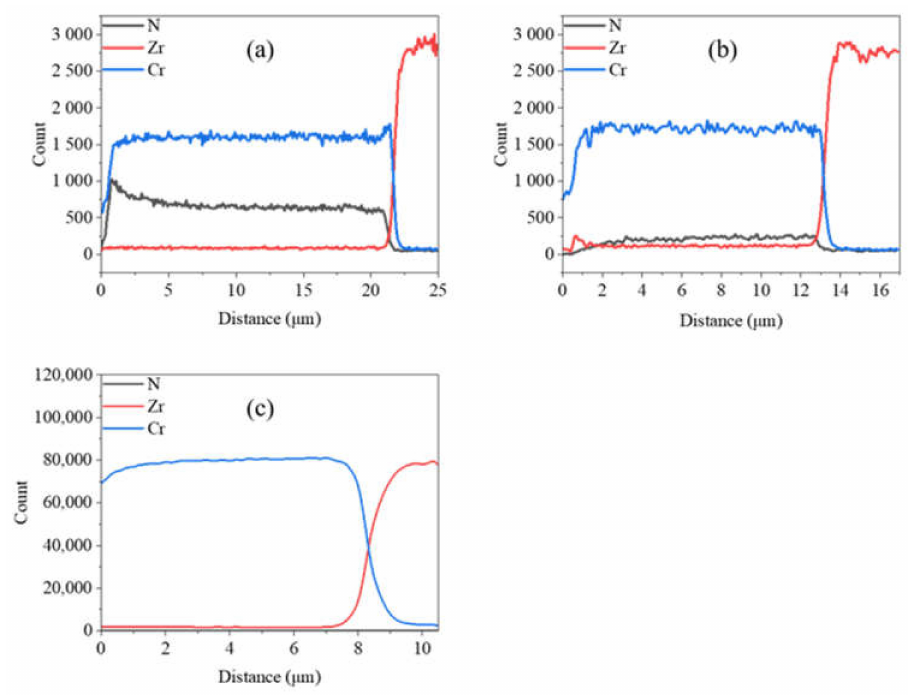
Figure 6. EDS analyses of ( a ) CrN, ( b ) Cr 2 N, and ( c ) Cr